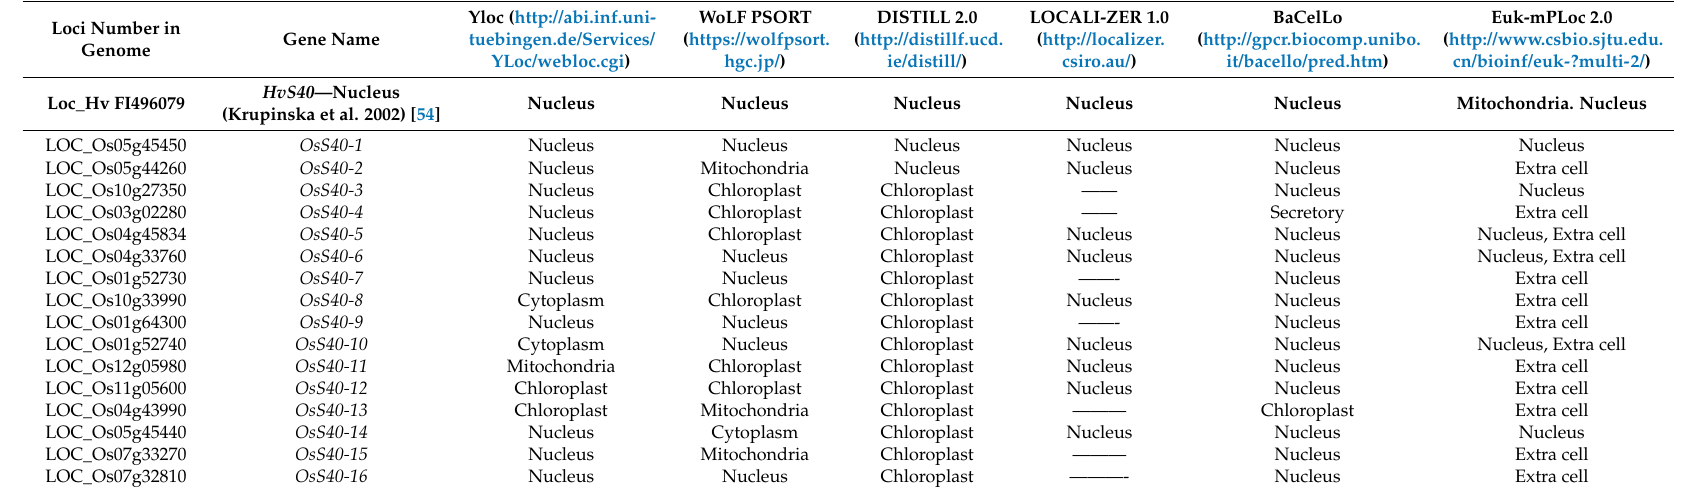
Table 2. The putative subcellular localization of S40 protein in rice